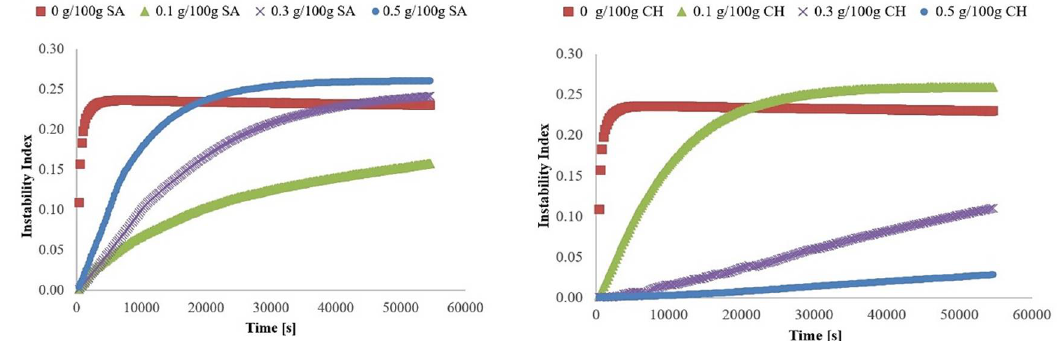
Figure 2. Influence of sodium alginate (SA) and chitosan (CH) addition on the destabilization of inulin hydrogels as a function of time.